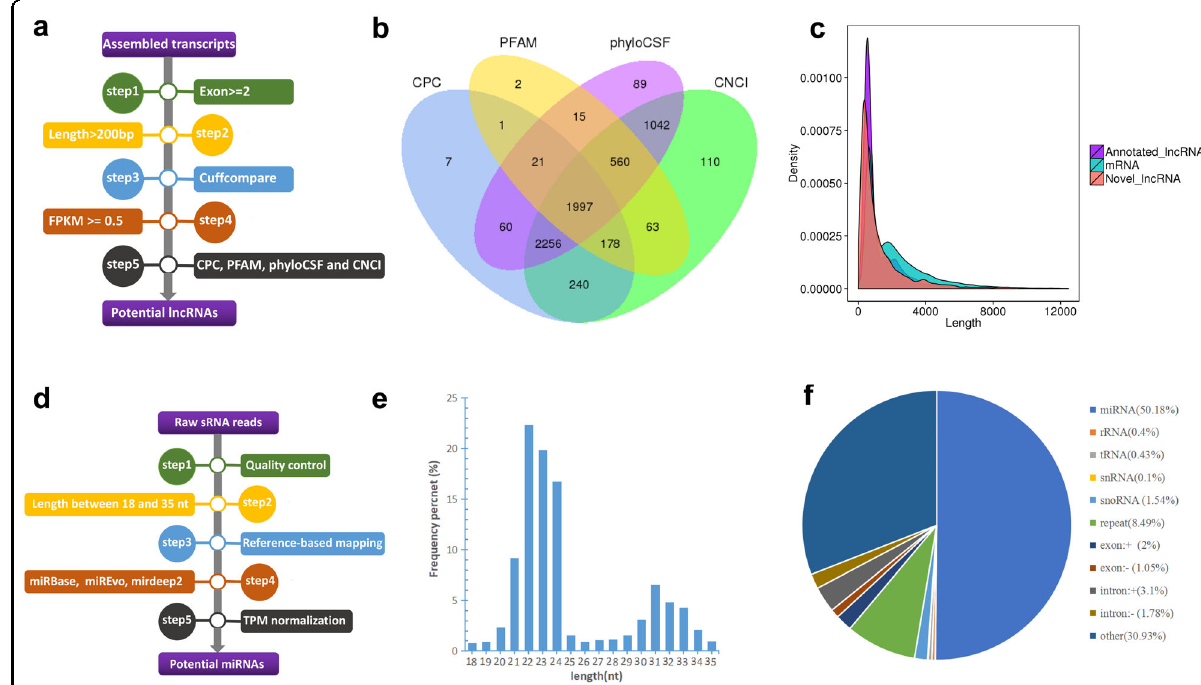
Fig. 1 Pro fi le of RNA expression in PA tissue. a Work fl ow of lncRNA analysis and screening. b Venn diagram showing coding potential screening results. c Comparison of the length of lncRNA and mRNA. d Work fl ow of sRNA analysis and screening. e Length distribution of sRNA fragments in IPA and NIPA libraries. f Classi fi cation and proportion of all